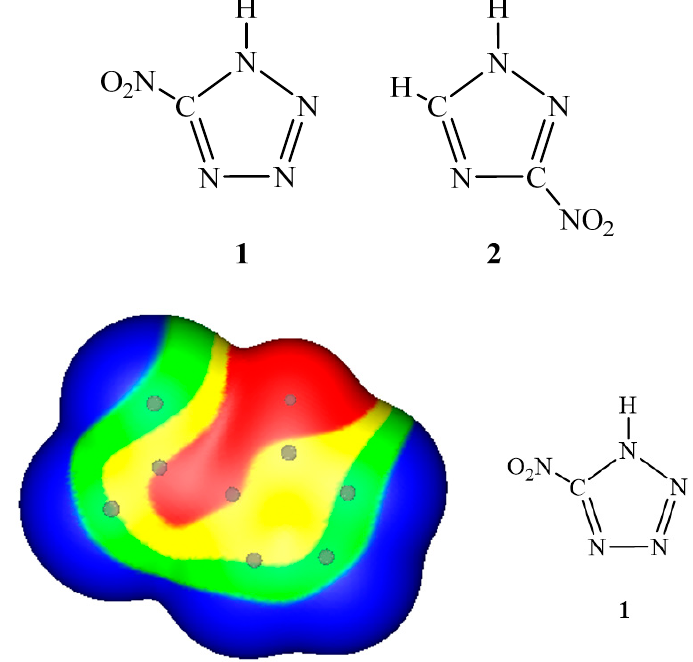
Figure 1. Computed electrostatic potential on 0.001 au molecular surface of 5-nitrotetrazole ( 1 ). Color ranges, in kcal/mol, are: red, greater than 30; yellow, between 30 and 15; green, between 15 and 0; blue, negative (less than 0). Circles show positions of atoms; NO 2 group is on the left. Most positive potential is 73 kcal/mol by the hydrogen; most negative are − 29 kcal/mol by the ring nitrogen at the bottom right.